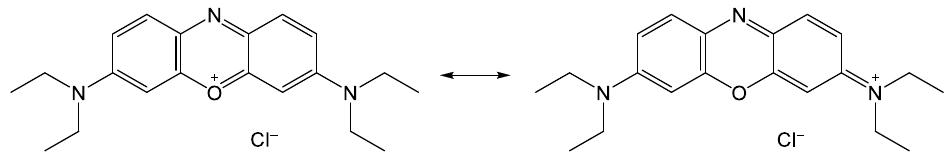
Figure 1. Structural formulae of C.I. Basic Blue 3 (BB 3).